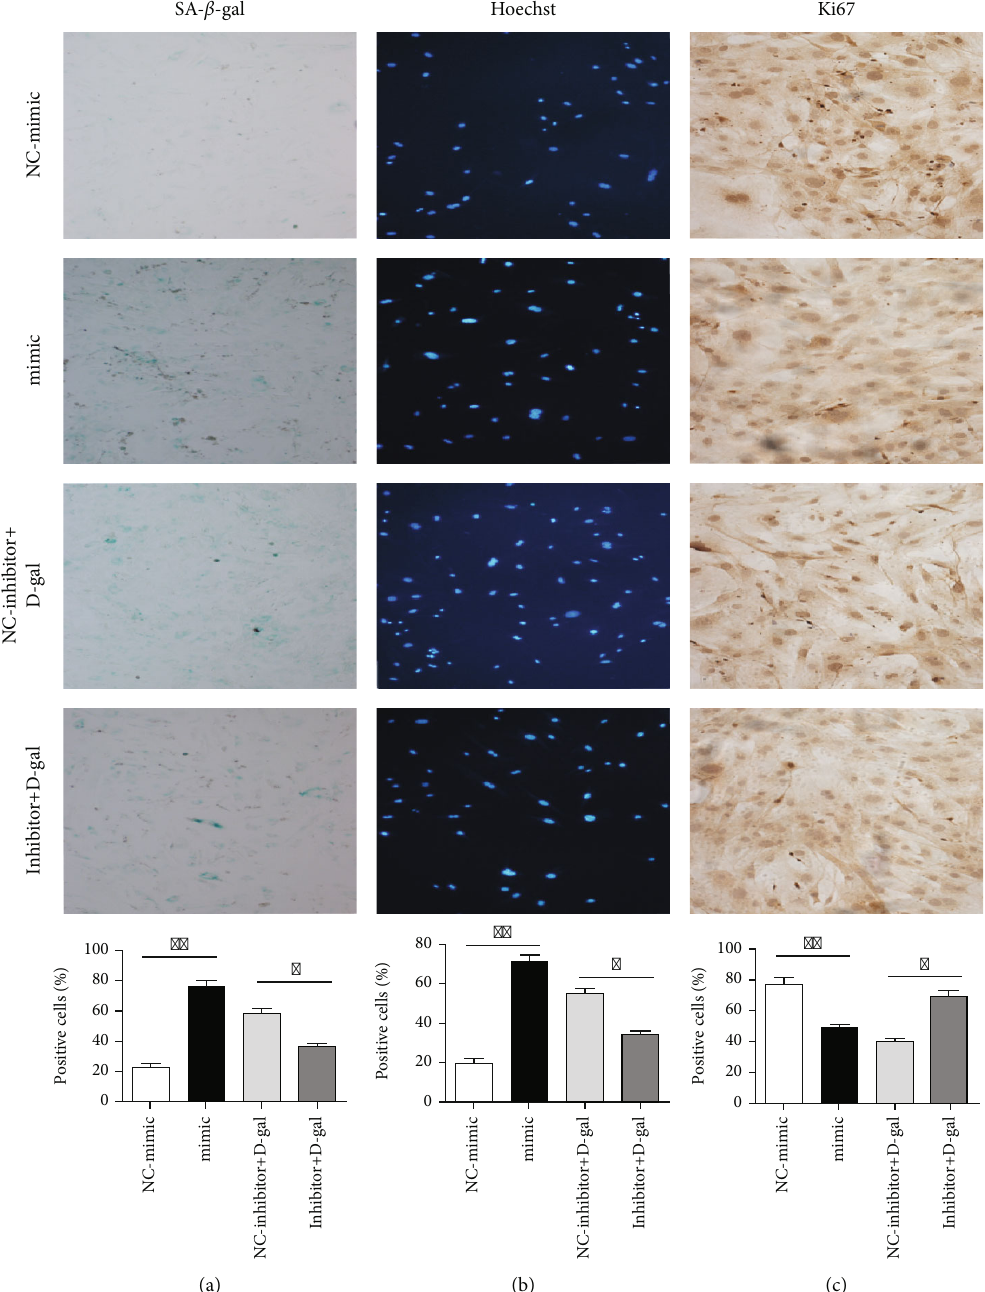
Figure 3: miR-326-3p regulated skin fi broblasts biological functions. (a) SA- β -gal staining assay of skin fi broblast cells after treated with miR-326-3p mimic/inhibitor (10 × ). (b) Apoptosis (Hoechst 33258) staining assay of skin fi broblast cells after treated with miR-326-3p mimic/inhibitor (10 × ). (c) Ki67 proliferation staining assay of skin fi broblast cells after treated with miR-326-3p mimic/inhibitor (10 × ). ∗ p < 0 : 05 vs. NC, ∗∗ p < 0 : 01 vs. NC. NC: negative